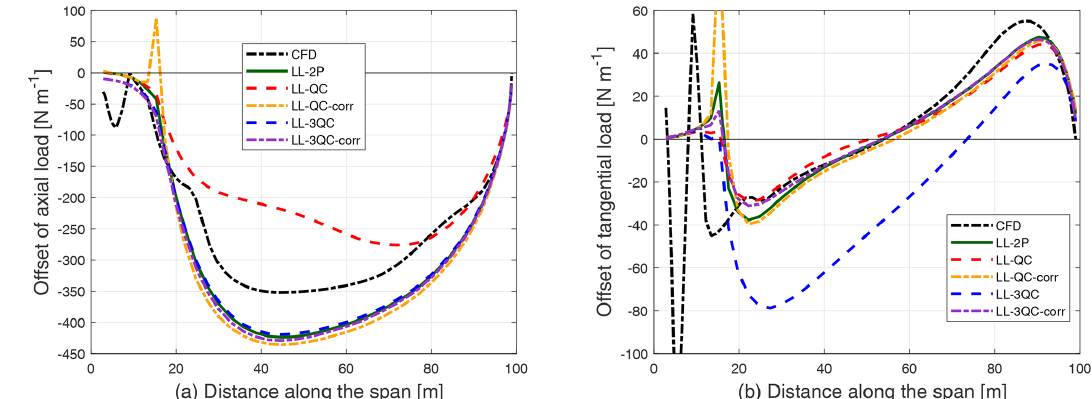
Figure 11. Comparison of the difference in the axial load (a) and tangential load (b) of the straight blade with 15 ◦ of upwind coning compared to the straight blade with zero cone angle, calculated from different implementations of the LL method and the fully resolved